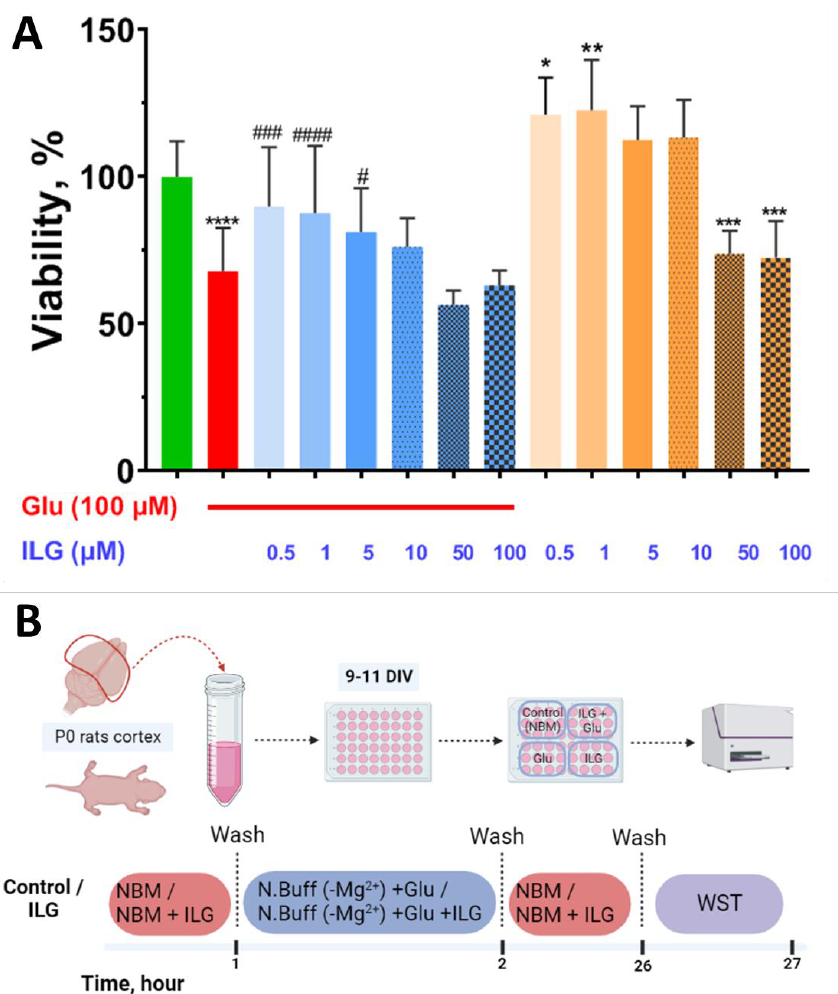
Figure 1. Effect of ILG (0.5 – 100 µM) on the survival of neuroglial culture cells under conditions of glutamate excitotoxicity (WST test). ( A ) Average viability in groups, determined using the WST test. ( B ) Scheme of experiments with a sequence of drug additions and timeline. Data are represented as M ± SEM . Five experiments were performed (4 – 8 wells per group in an experiment). * p < 0.05 compared to control; ** p < 0.01 compared to control; *** p < 0.001 compared to control; **** p < 0.0001 compared to control; # p < 0.05 compared to glutamate; ### p < 0.001 compared to glutamate; #### p < 0.0001 compared to glutamate.